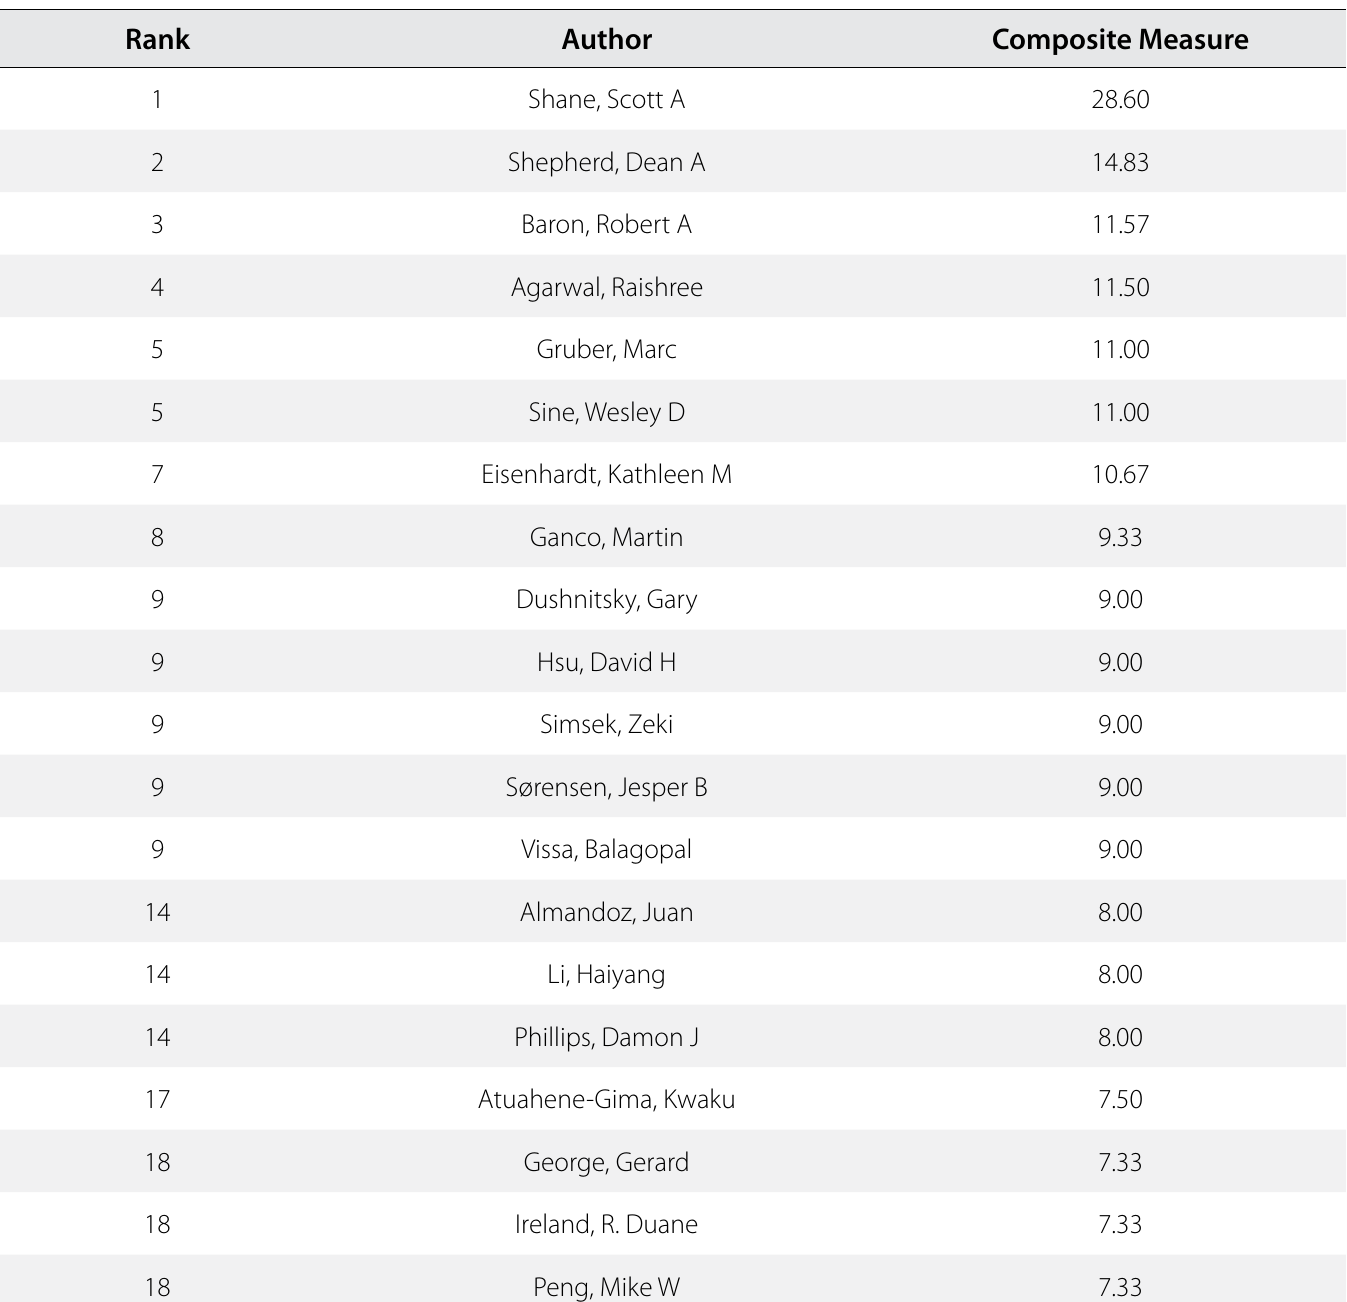
Table 6. Top Authors Ranked by Composite Measure